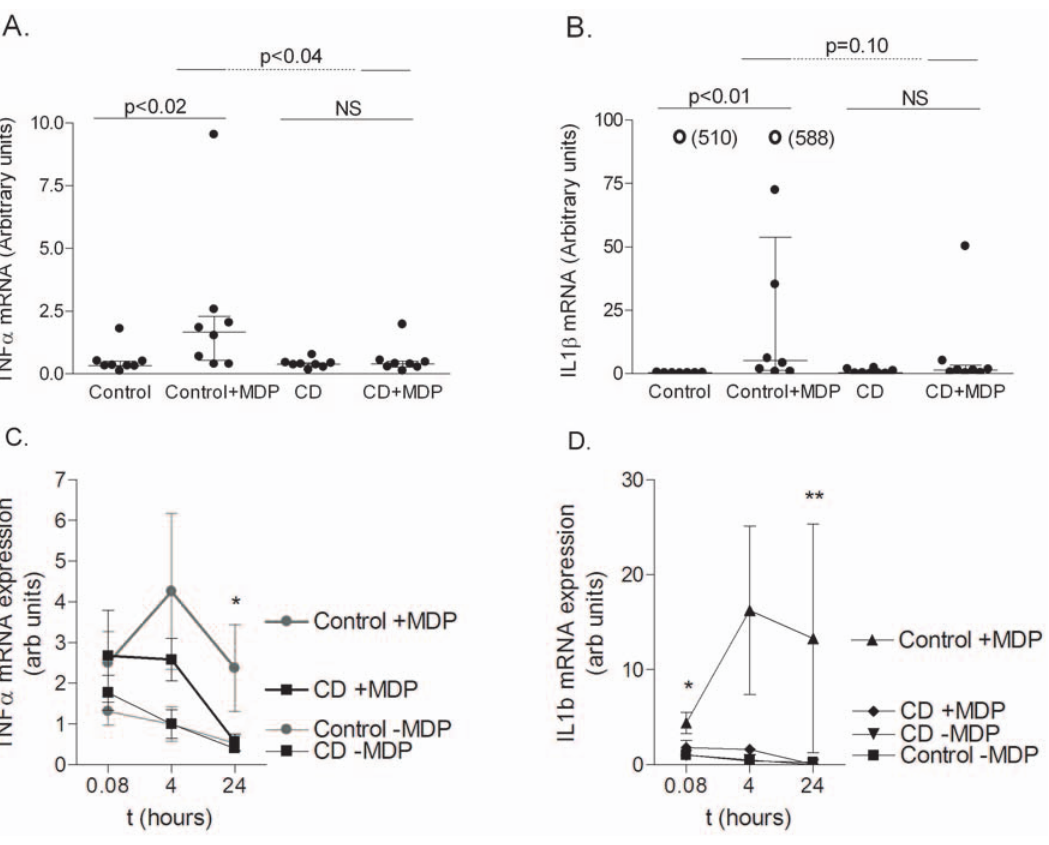
Figure 1. Kinetics of MDP-induced mRNA expression of TNF- a and IL-1 b . RT-qPCR of mRNA of TNF- a (A) and IL-1 b (B). Kinetic studies of mRNA-response (C and D). Isolated monocytes were stimulated for 5 minutes (0.08 hours), 4 hours and 24 hours. Stimulation with MDP increased the level of mRNA transcription in monocytes from control subjects (p , 0.01 and p , 0.02 for TNF- a and IL-1 b , respectively), whereas an upregulation was not seen in monocytes isolated from CARD15 non-mutated CD patients. Arbitrary units. Due to high variability in IL1 b expression in both control and CD patients, these expression data were normalised to expression values at t=0 hours. *p , 0.05; **p , 0.01.